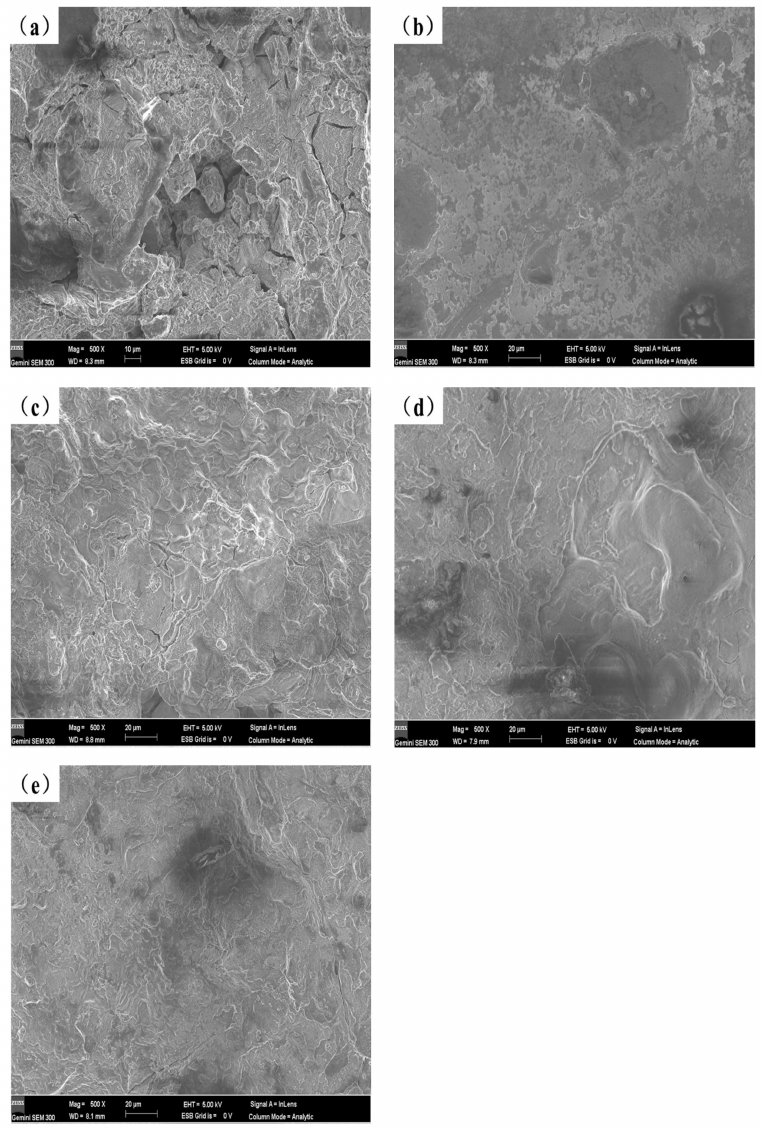
Figure 10. Surface morphology of different coatings after corrosion test in 3.5 wt.% NaCl solution: ( a ) AZ91D, ( b ) AS, ( c ) AS1Y, ( d ) AS1.5Y, ( e )